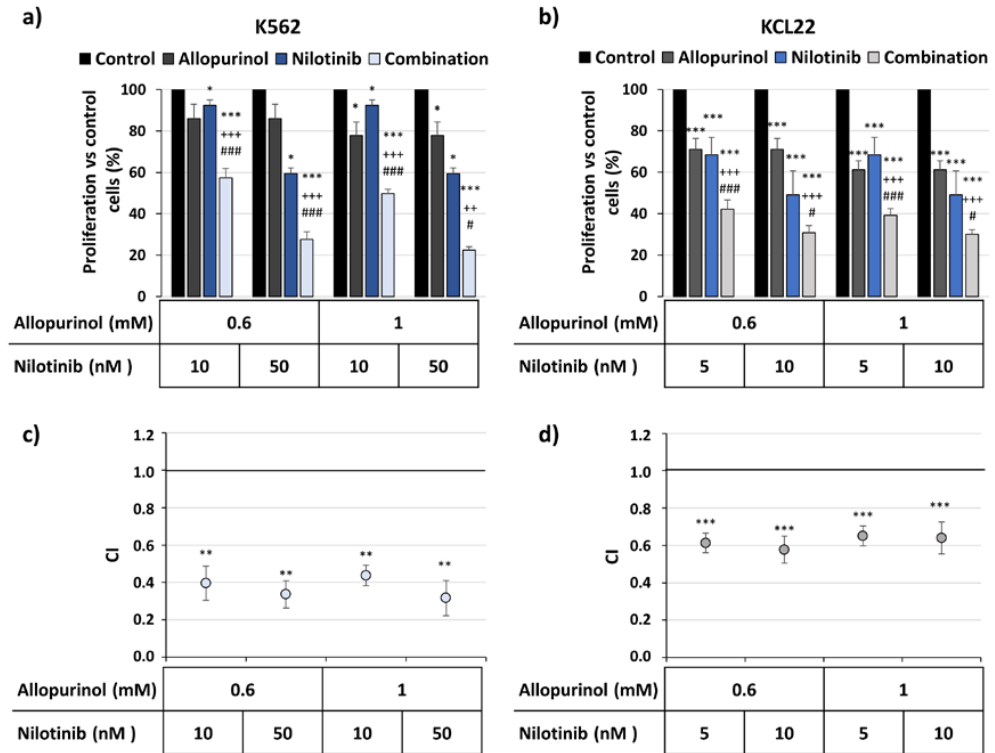
Figure 3. The combination of nilotinib and allopurinol reduces the proliferation of the K562 and KCL22 cells in a synergistic manner. K562 and KCL22 cells were treated with different concentrations of nilotinib, allopurinol, or their combination for 48 h. Proliferation was analyzed by MTT assay and the combination indexes (CI) were calculated as described in the Methods section. ( a ) K562 cells proliferation with respect to control ( n = 3). ( b ) KCL22 cells proliferation with respect to control ( n = 5). Significant differences: *** p < 0.001 with respect to control, * p < 0.05; +++ p < 0.001, ++ p < 0.01 with respect to allopurinol-treated cells; ### p < 0.001, # p < 0.05 with respect to nilotinib-treated cells. ( c ) Mean CI values for the drug combinations tested in K562 cells ( n = 3). ( d ) Mean CI values for the drug combinations tested in KCL22 cells ( n = 5). *** p < 0.001 and ** p < 0.01 reflect significant differences with respect to CI value 1.